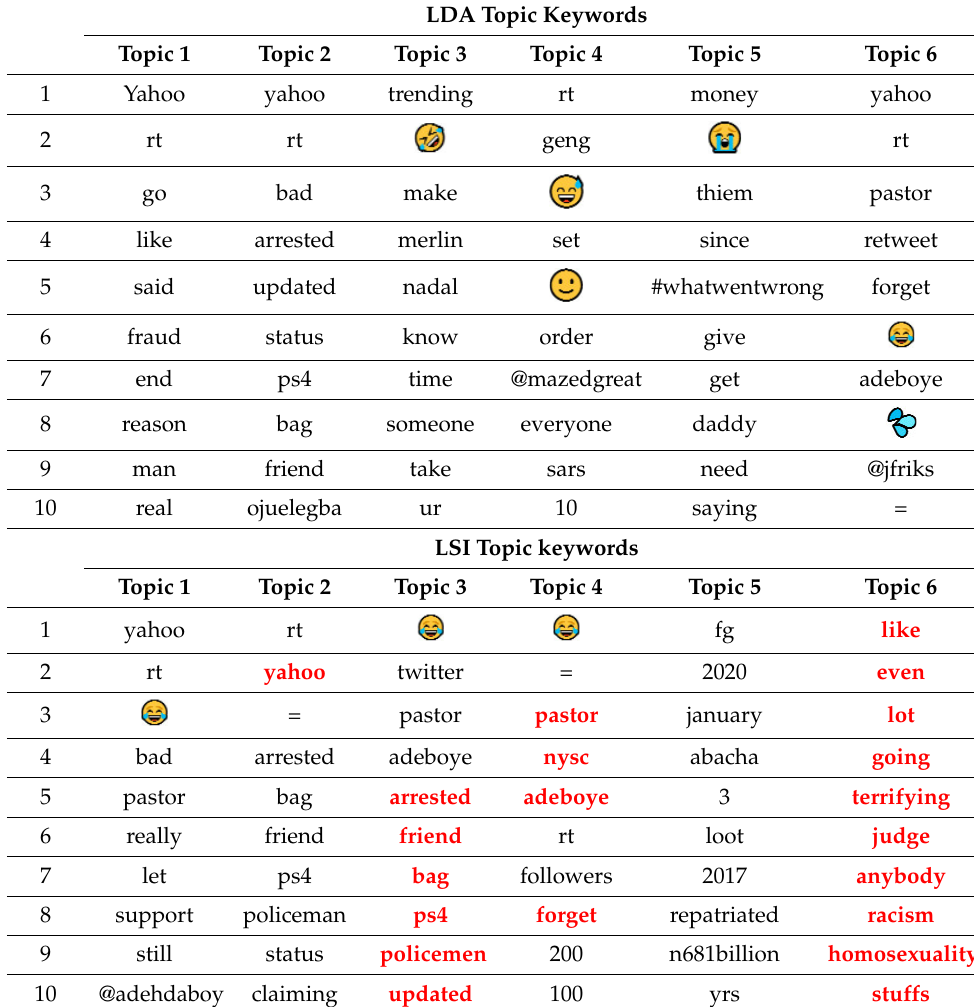
Table 4. Showing LDA and LSI generated topics with keywords. LDA Topic